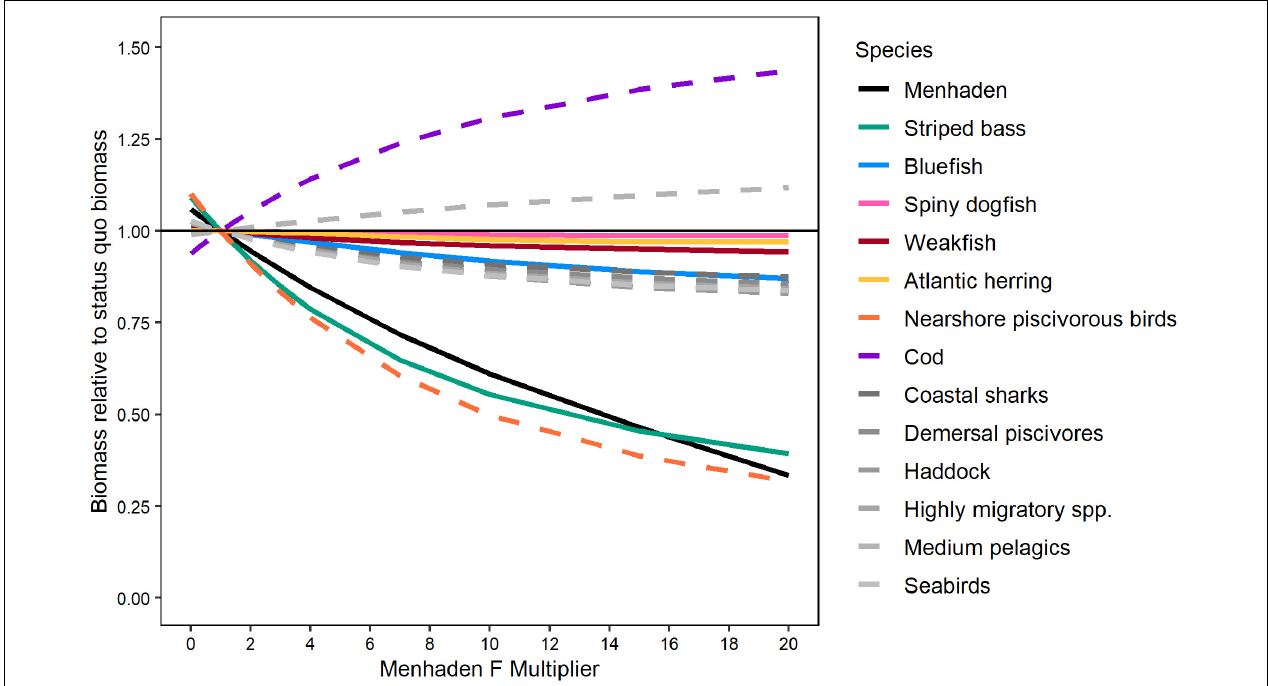
FIGURE 5 | Effect of Atlantic menhaden fishing on equilibrium biomass of select trophic groups (projected for 50 years) relative to their equilibrium biomass under status quo Atlantic menhaden fishing rates from the EwE-Full model. ERP focal species were fished at their target F while Atlantic menhaden F rates were scaled from 0 to 20 times the 2017 values using an F -multiplier. Lines are plotted for all ERP focal species and other trophic groups with non-negligible ( > 15%) responses. Solid lines indicate species included in both the EwE-Full and EwE-MICE models, while dashed lines indicate species or species groups included only in the EwE-Full